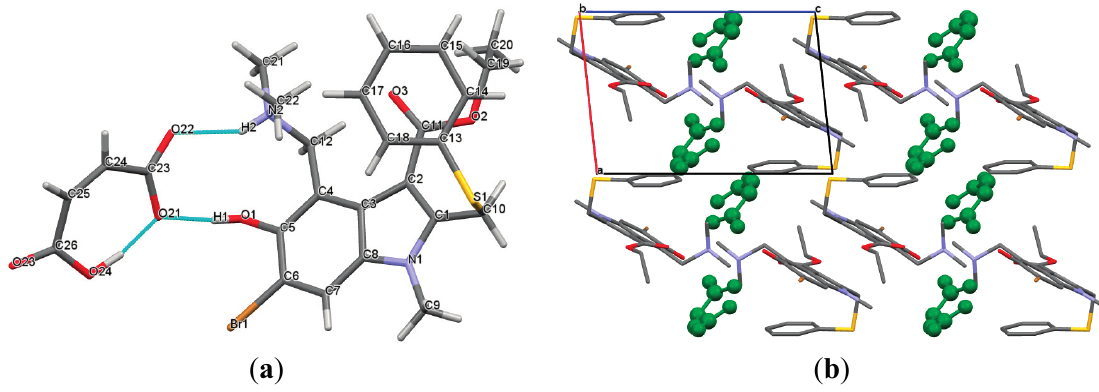
Figure 2. ( a ) Hydrogen bonded molecular unit in the [ Arb + Mlc ] crystal; ( b ) molecular packing projections for [ Arb + Mlc ]. Maleic acid molecules are colored in green. H atoms are